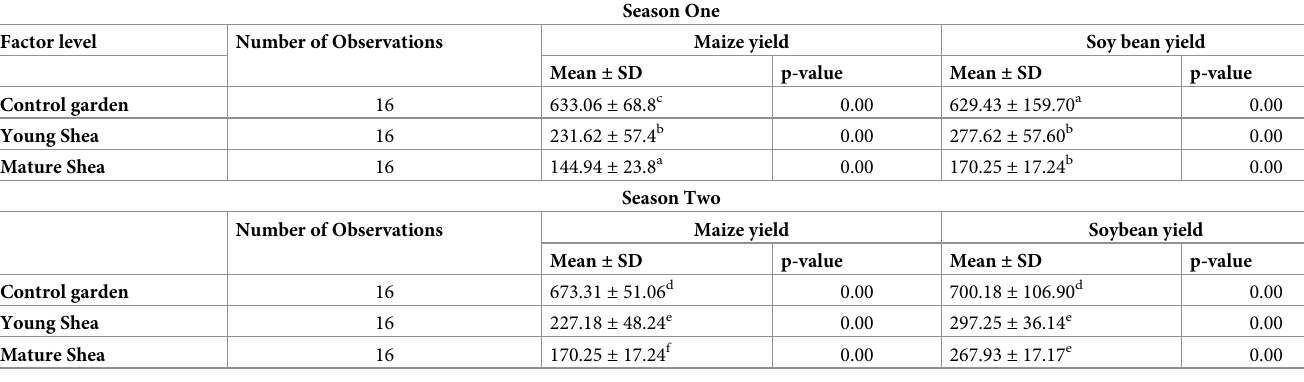
Table 2. Variation in maize and soy bean yield under Mature/Young Shea and